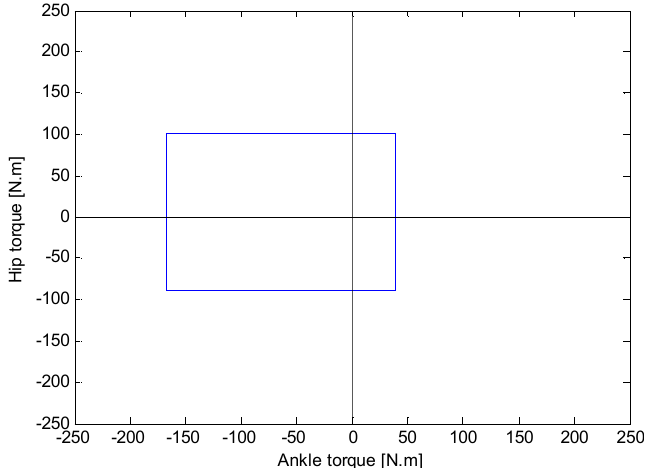
Figure 4. The control input constraint used in this example. The input (ankle and hip torque) may take values only from inside the blue rectangle. It is also called the feasible input